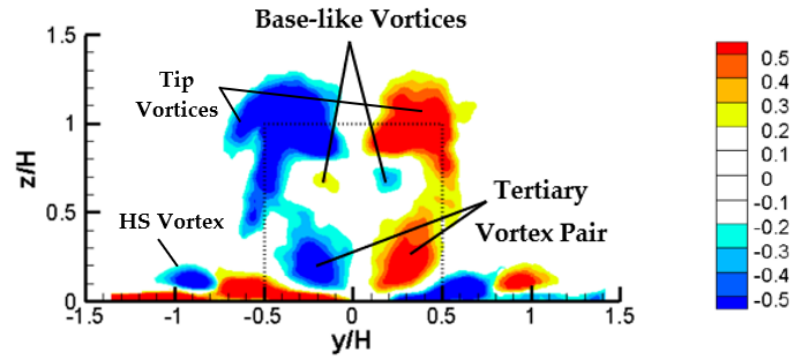
Figure 8. Naming convention of the main vortex structures identified in the cylinder wake.